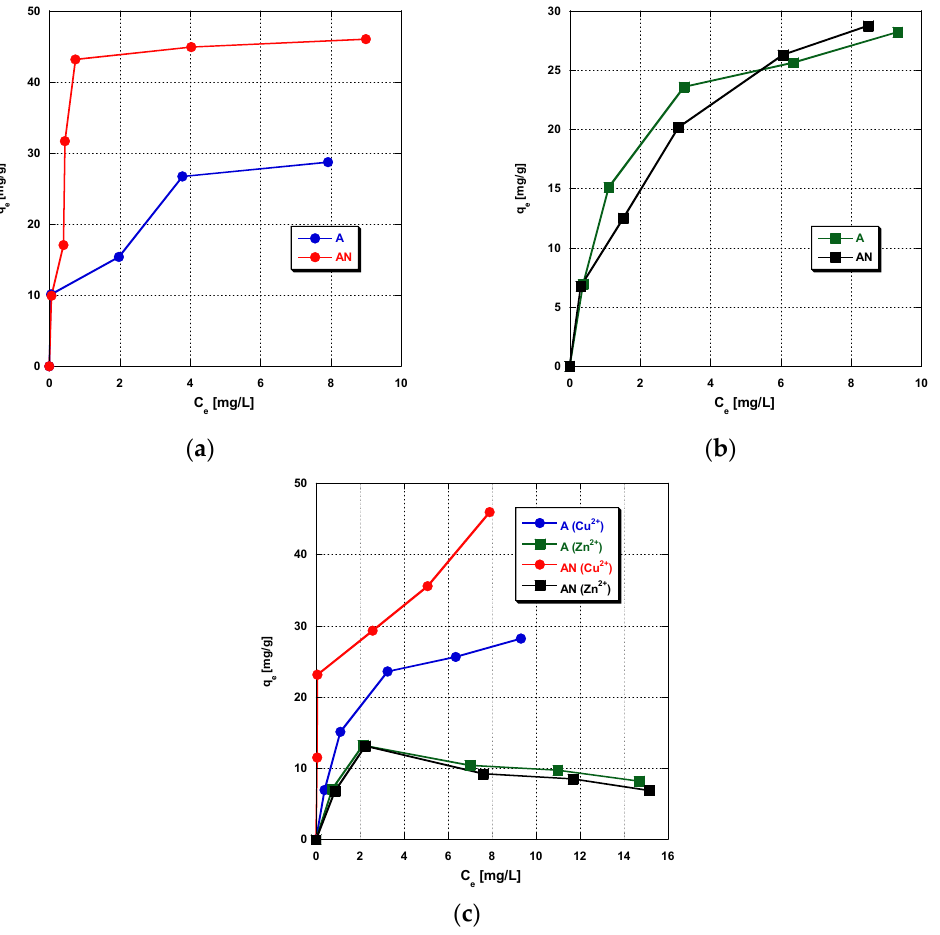
Figure 3. The effect of the initial heavy metal ion concentration on ( a ) Cu(II) ions’ adsorption, ( b ) Zn(II) ions’ adsorption, and ( c ) simultaneous adsorption of Zn(II) and Cu(II) (pH 6, time 240 min, shaking speed 180 rpm, temperature: 22 ± 2 °C).